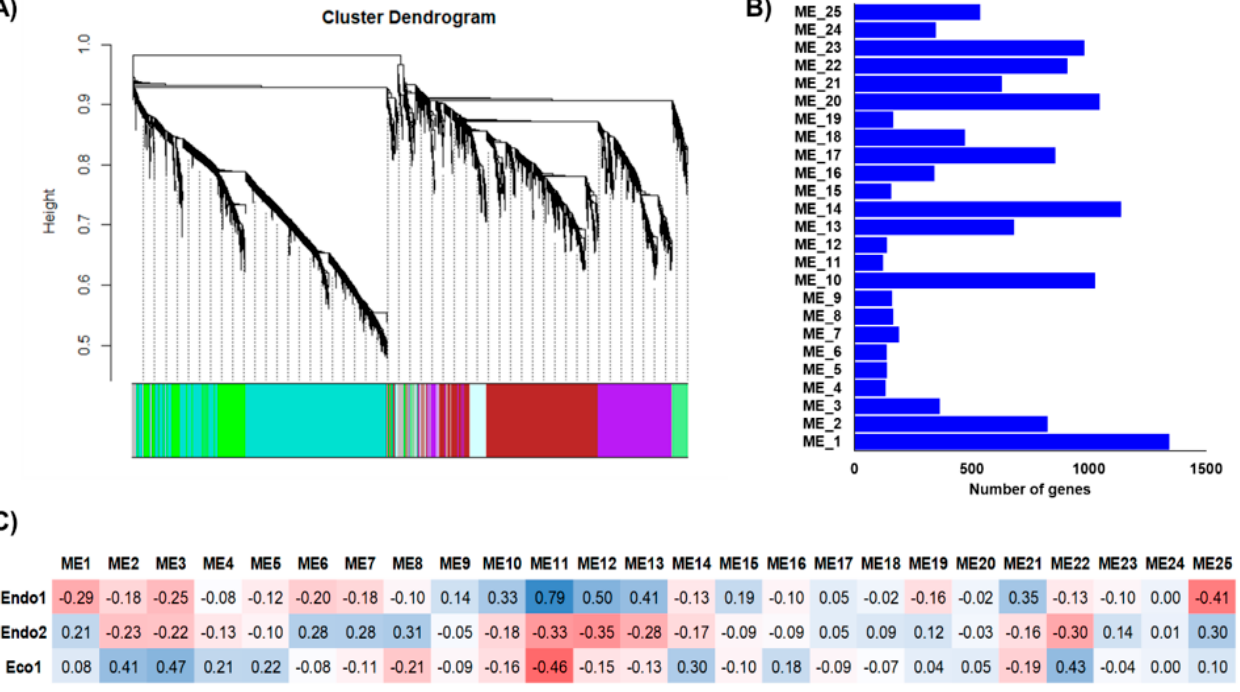
Figure 4. Integrated co-expression networks constructed using almond, apricot, peach, and sweet cherry differentially expressed genes. ( A ) Dendrograms of gene clustering based on RNAseq data. ( B ) Number of genes in each module. ( C ) Correlations ( p − values) between modules and dormancy stages (red and blue colorations indicate a negative and positive correlation, respectively).